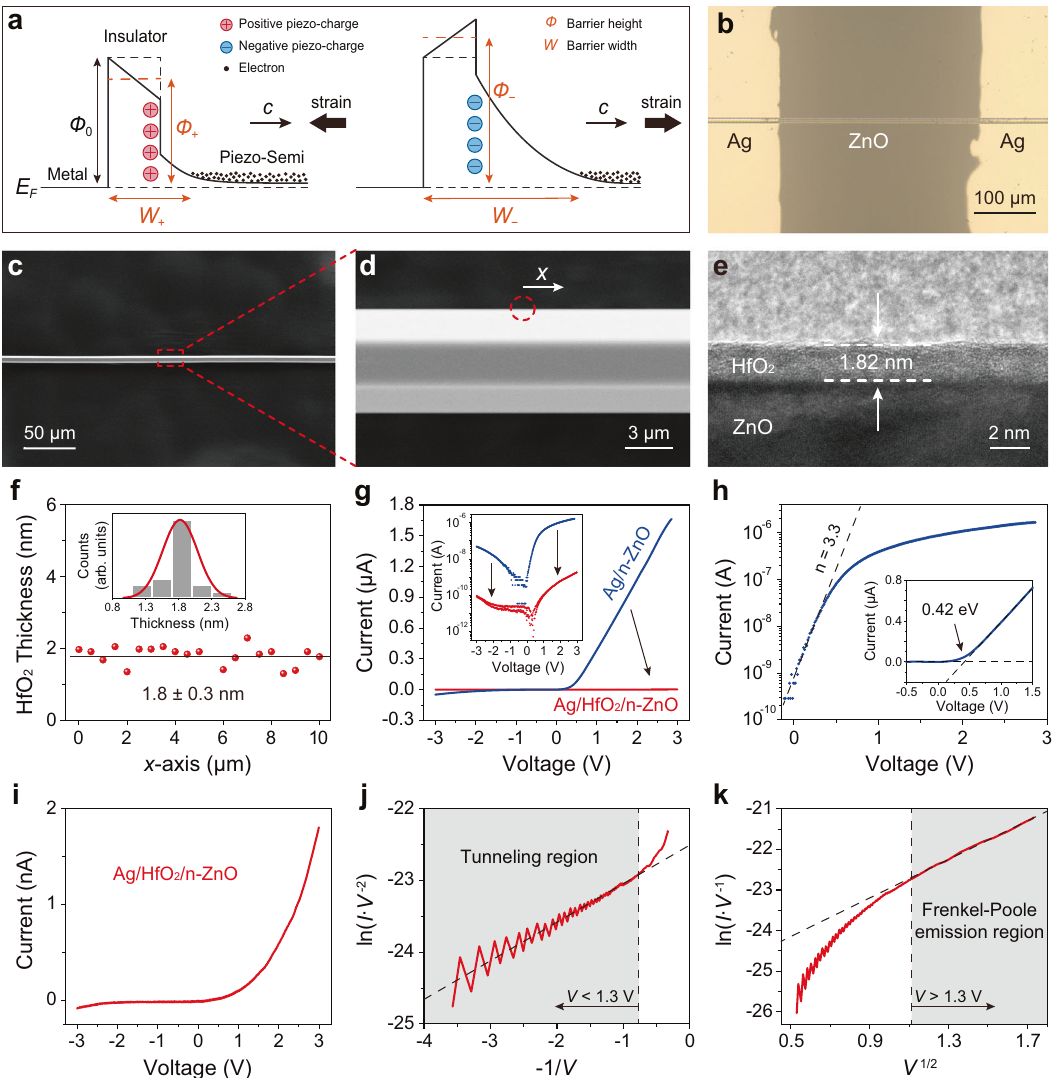
Fig. 1 The working principle, structure and electrical transport of strain sensor based on piezotronic tunneling junction. a Schematics of the metal/ insulator/piezoelectric semiconductor structure of piezotronic tunneling junction and corresponding conduction energy band pro fi les for the positive (left) and negative (right) piezoelectric polarizations at interfaces. A n-type semiconductor is taken as an example. Strain-induced positive piezoelectric polarization charges simultaneously decrease the tunneling barrier height ( ϕ þ ) and width ( W þ ), which corresponds to the low resistance state of strain sensor; while, strain-induced negative piezoelectric polarization charges simultaneously increase the tunneling barrier height ( ϕ (cid:2) ) and width ( W (cid:2) ), which corresponds to the high resistance state of strain sensor. The energy band diagrams with and without piezoelectric charges are shown by the black solid and dashed lines, respectively. b Optical image of the piezotronic tunneling strain sensor, an individual n-ZnO nanowire coated with atomic thickness of HfO 2 insulator, clamping at its two ends by Ag electrodes. c , d SEM images of the ZnO nanowire with a diameter of about 8 μ m, showing a typical hexagonal geometry and a clean surface. e , f High-resolution TEM image of HfO 2 deposited on ZnO surface and the distribution of HfO 2 thickness along the x -axis in d , showing the HfO 2 thickness of about 1.8 (±0.3) nm. The inset shows the statistical distribution of the insulating thickness. g – k Carrier transports of the Ag/HfO 2 /n-ZnO piezotronic tunneling junction (red curves) and the Ag/n-ZnO Schottky junction (blue curves) without strain. The semilogarithmic I – V curve of Ag/n-ZnO ( h ) shows a Schottky barrier height of about 0.42 eV and an ideal factor of about 3.3. The I – V ( i ), ln( I ∙ V − 2 ) versus -1/ V ( j ), and ln( I ∙ V − 1 ) versus V 1/2 ( k ) curves of Ag/HfO 2 /n-ZnO indicate that tunneling and Frankel-Poole emission correspond to carrier transport mechanisms at low and high bias voltages, respectively. Ag electrodes clamped at the nanowire ’ s ends (Fig. 1b). The ZnO piezoresponse force microscopy (PFM) and the nanogenerator nanowires were grown by chemical vapor deposition and trans- measurement, respectively (Supplementary Note 2 and Supple- ferred to a fl exible substrate PET. Scanning electron microscopy mentary Figs. 3 and 4). The insulating layer HfO 2 was precisely grown on the ZnO nanowire by atomic layer deposition (ALD). (SEM) images, transmission electron microscopy (TEM) images High-resolution transmission electron microscopy (HTEM) and X-ray diffraction spectra show that the uniform ZnO nano- image of HfO 2 (Fig. 1e) deposited on ZnO surface and the sta- wire with a typical hexagonal geometry has a clean surface and a tistical distribution of HfO 2 thickness (Fig. 1f) along the x -axis good wurtzite crystallinity (Fig. 1c, d and Supplementary Note 1 labeled in Fig. 1d, indicate the HfO 2 is uniform with a thickness and Supplementary Figs. 1 and 2). Its piezoelectric property and of about 1.8 (±0.3) nm. polarization c -axis can be obtained and determined through the NATURE COMMUNICATIONS| (2022) 13:778